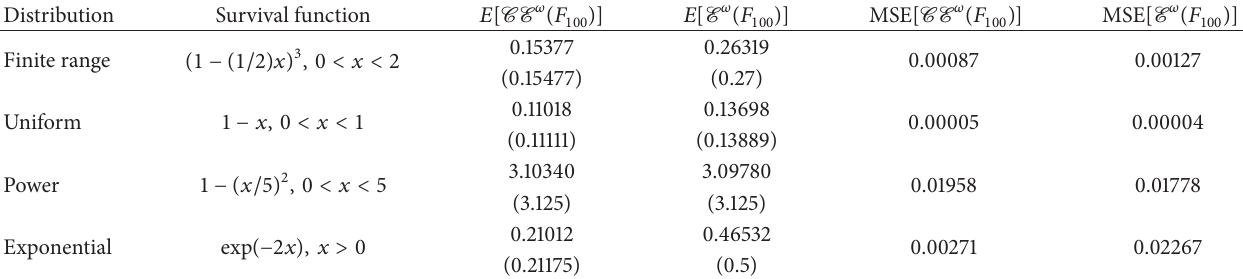
Table 1: Mean and MSE of the empirical cumulative entropy for random samples of some familiar